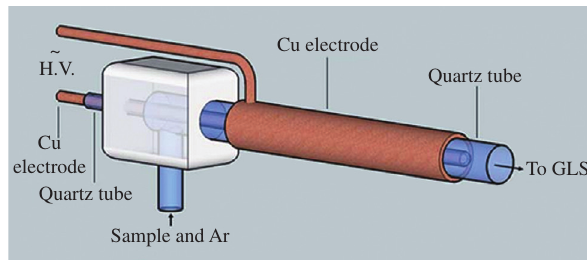
Figure 2 Chromatogram of shrimp tissue extract sample spiked with or without 100 μ g l -1 of each Hg species by HPLC-SCGD-AFS system. Reproduced from He et al. (2011) with permission of